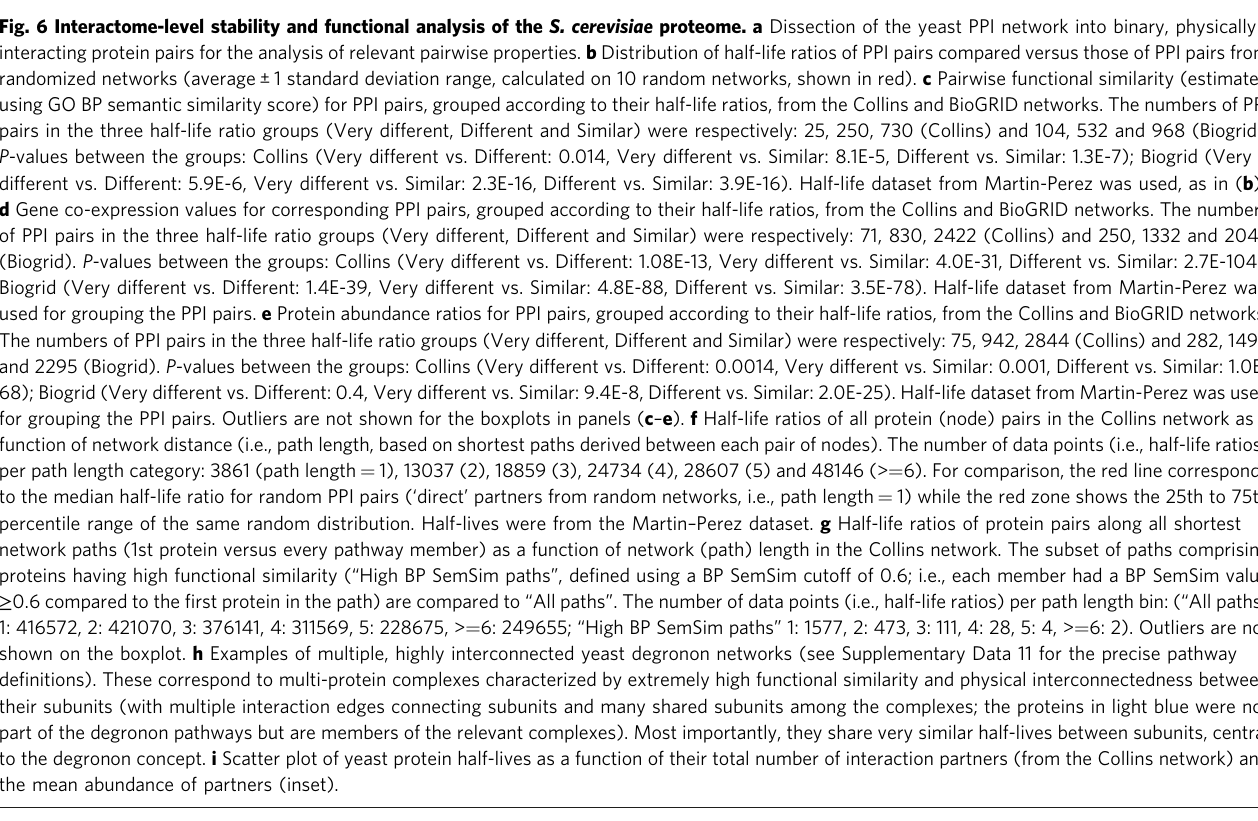
Fig. 6 Interactome-level stability and functional analysis of the S. cerevisiae proteome. a Dissection of the yeast PPI network into binary, physically interacting protein pairs for the analysis of relevant pairwise properties. b Distribution of half-life ratios of PPI pairs compared versus those of PPI pairs from randomized networks (average ± 1 standard deviation range, calculated on 10 random networks, shown in red). c Pairwise functional similarity (estimated using GO BP semantic similarity score) for PPI pairs, grouped according to their half-life ratios, from the Collins and BioGRID networks. The numbers of PPI pairs in the three half-life ratio groups (Very different, Different and Similar) were respectively: 25, 250, 730 (Collins) and 104, 532 and 968 (Biogrid). P -values between the groups: Collins (Very different vs. Different: 0.014, Very different vs. Similar: 8.1E-5, Different vs. Similar: 1.3E-7); Biogrid (Very different vs. Different: 5.9E-6, Very different vs. Similar: 2.3E-16, Different vs. Similar: 3.9E-16). Half-life dataset from Martin-Perez was used, as in ( b ). d Gene co-expression values for corresponding PPI pairs, grouped according to their half-life ratios, from the Collins and BioGRID networks. The numbers of PPI pairs in the three half-life ratio groups (Very different, Different and Similar) were respectively: 71, 830, 2422 (Collins) and 250, 1332 and 2047 (Biogrid). P -values between the groups: Collins (Very different vs. Different: 1.08E-13, Very different vs. Similar: 4.0E-31, Different vs. Similar: 2.7E-104); Biogrid (Very different vs. Different: 1.4E-39, Very different vs. Similar: 4.8E-88, Different vs. Similar: 3.5E-78). Half-life dataset from Martin-Perez was used for grouping the PPI pairs. e Protein abundance ratios for PPI pairs, grouped according to their half-life ratios, from the Collins and BioGRID networks. The numbers of PPI pairs in the three half-life ratio groups (Very different, Different and Similar) were respectively: 75, 942, 2844 (Collins) and 282, 1498 and 2295 (Biogrid). P -values between the groups: Collins (Very different vs. Different: 0.0014, Very different vs. Similar: 0.001, Different vs. Similar: 1.0E- 68); Biogrid (Very different vs. Different: 0.4, Very different vs. Similar: 9.4E-8, Different vs. Similar: 2.0E-25). Half-life dataset from Martin-Perez was used for grouping the PPI pairs. Outliers are not shown for the boxplots in panels ( c – e ). f Half-life ratios of all protein (node) pairs in the Collins network as a function of network distance (i.e., path length, based on shortest paths derived between each pair of nodes). The number of data points (i.e., half-life ratios) per path length category: 3861 (path length = 1), 13037 (2), 18859 (3), 24734 (4), 28607 (5) and 48146 (> = 6). For comparison, the red line corresponds to the median half-life ratio for random PPI pairs ( ‘ direct ’ partners from random networks, i.e., path length = 1) while the red zone shows the 25th to 75th percentile range of the same random distribution. Half-lives were from the Martin – Perez dataset. g Half-life ratios of protein pairs along all shortest network paths (1st protein versus every pathway member) as a function of network (path) length in the Collins network. The subset of paths comprising proteins having high functional similarity ( “ High BP SemSim paths ” , de fi ned using a BP SemSim cutoff of 0.6; i.e., each member had a BP SemSim value ≥ 0.6 compared to the fi rst protein in the path) are compared to “ All paths ” . The number of data points (i.e., half-life ratios) per path length bin: ( “ All paths ” 1: 416572, 2: 421070, 3: 376141, 4: 311569, 5: 228675, > = 6: 249655; “ High BP SemSim paths ” 1: 1577, 2: 473, 3: 111, 4: 28, 5: 4, > = 6: 2). Outliers are not shown on the boxplot. h Examples of multiple, highly interconnected yeast degronon networks (see Supplementary Data 11 for the precise pathway de fi nitions). These correspond to multi-protein complexes characterized by extremely high functional similarity and physical interconnectedness between their subunits (with multiple interaction edges connecting subunits and many shared subunits among the complexes; the proteins in light blue were not part of the degronon pathways but are members of the relevant complexes). Most importantly, they share very similar half-lives between subunits, central to the degronon concept. i Scatter plot of yeast protein half-lives as a function of their total number of interaction partners (from the Collins network) and the mean abundance of partners